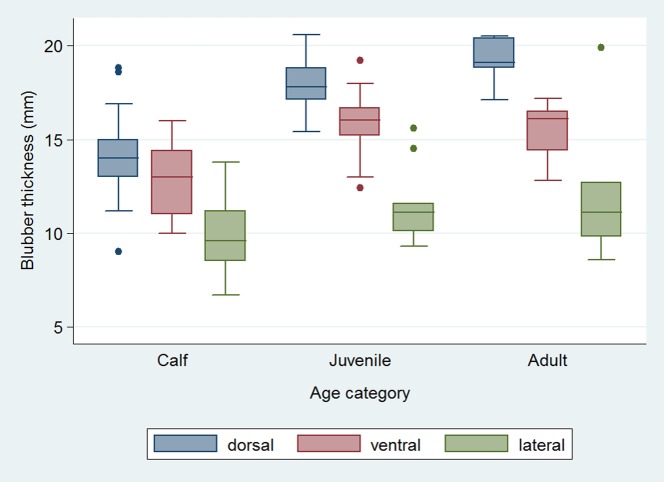
Blubber thickness (mm) of T. aduncus in three age classes.Box extends from 25th to 75th percentile, horizontal line represents the median, whiskers extend to the smallest and largest observations that are <1.5 times removed from the interquartile range (IQR), and dots represent outliers.